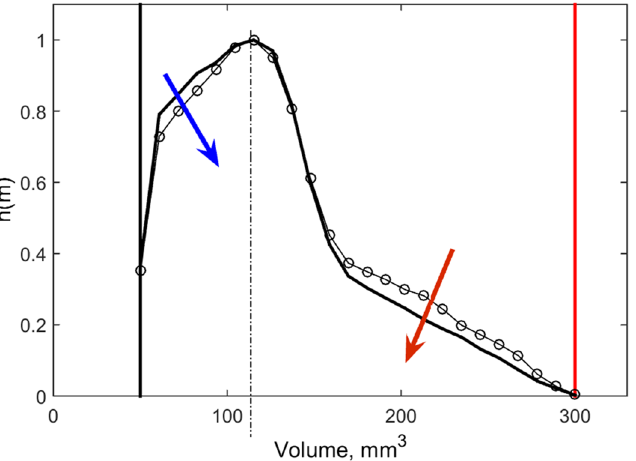
Figure 6. Final volume distributions after long runs. It is seen that the maximums coincide already. Remaining trends of the histogram alterations for the distribution started from the large (open circles) and small (closed circles) individuals are marked by the red and blue arrows